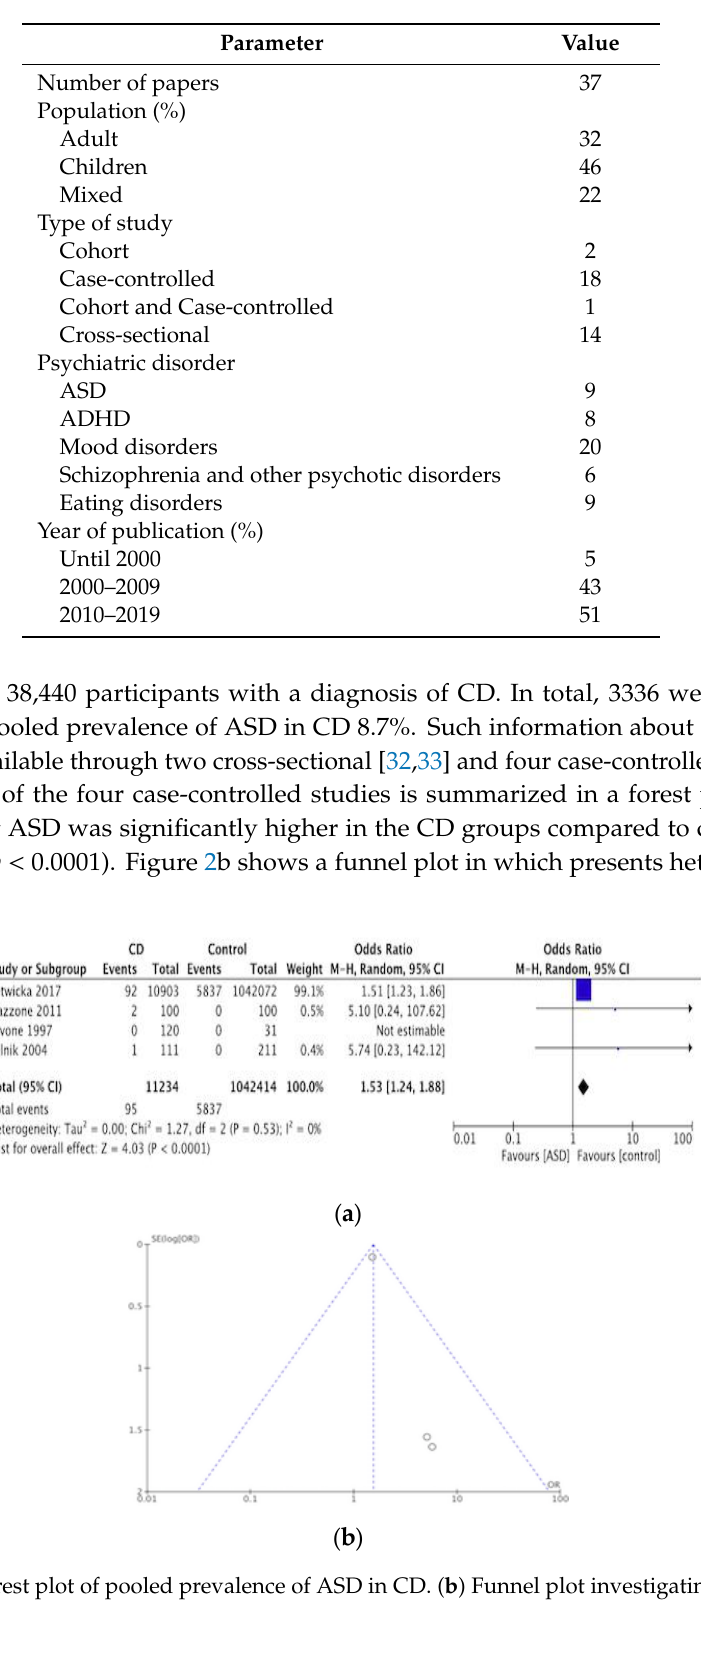
Table 1. Characteristics of studies included in this review